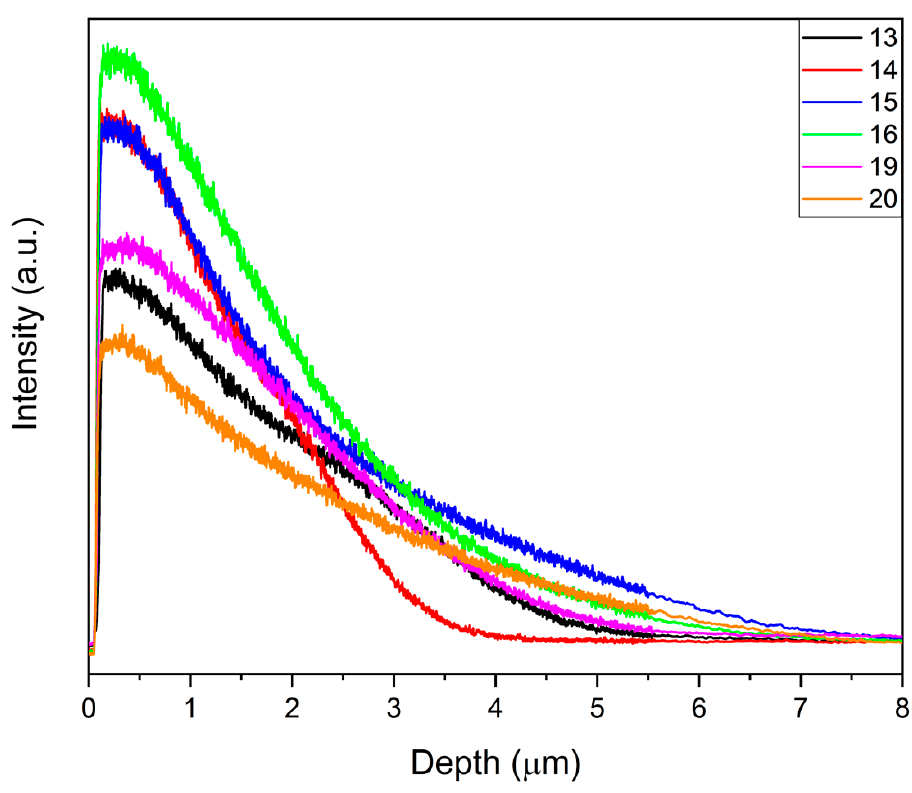
Figure 12. Comparison of Nb GDOES profiles of different samples of the second set. Table 9. Nb mean content calculated from GDOES data of set II.